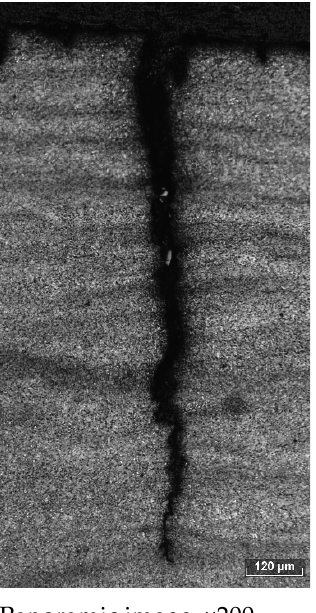
Figure 3. Secondary cracks in microstructure of the specimen after testing on SSC.